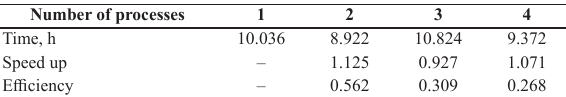
Table 2. Basov-cluster implementation of ODETTA code